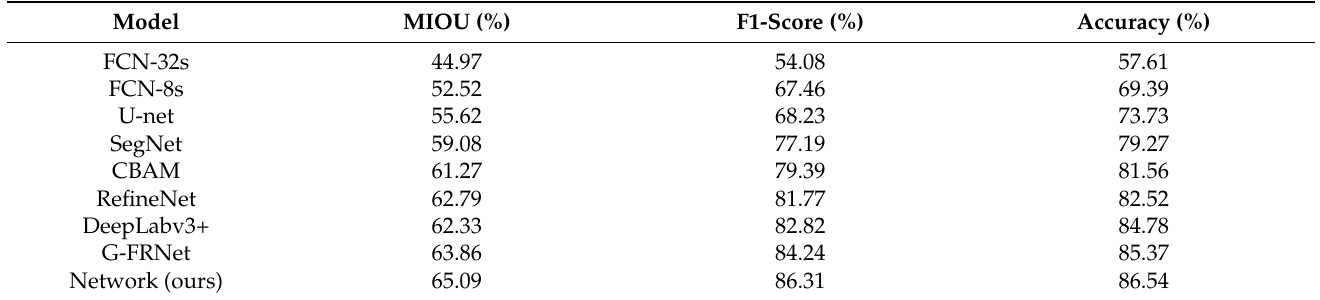
Table 3. Semantic segmentation results of the round grain rice dataset. The index results of MIOU, F1-score and accuracy of each